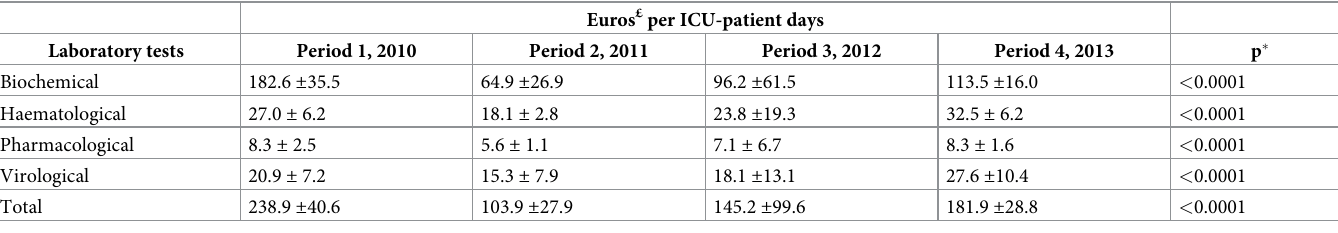
Table 5. Comparison of laboratory tests costs in ICU A according to different periods.